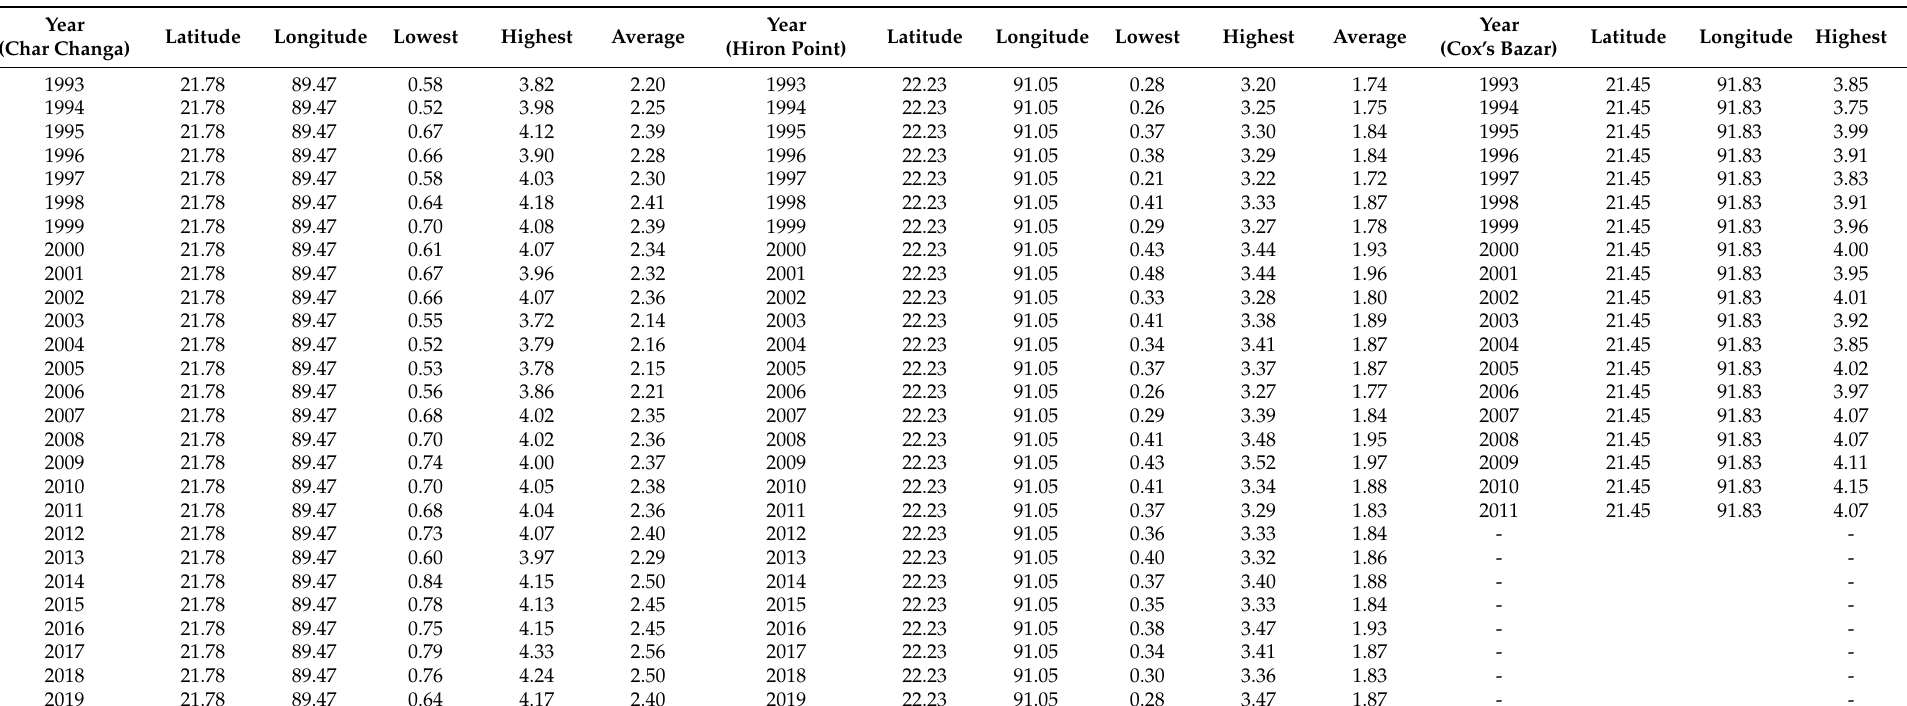
Table 1. Data from three tide gauge stations from the Bay of Bengal at Hiron Point, Char Changa, and Cox’s Bazar (primary data were collected from Government of Bangladesh Inland Waterways and Transportation Authority